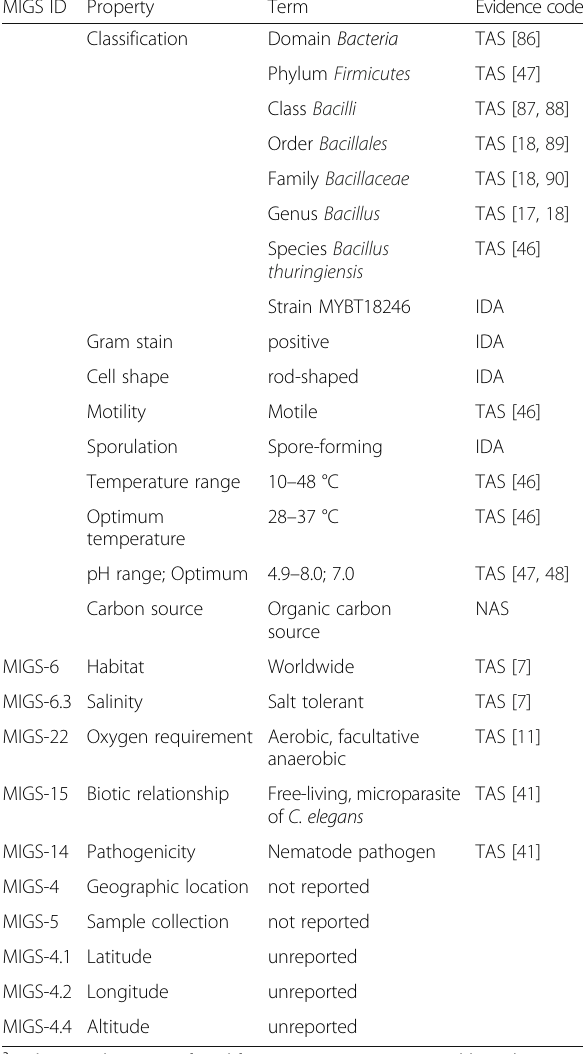
Table 1 Classification and general features of B. thuringiensis MYBT18246